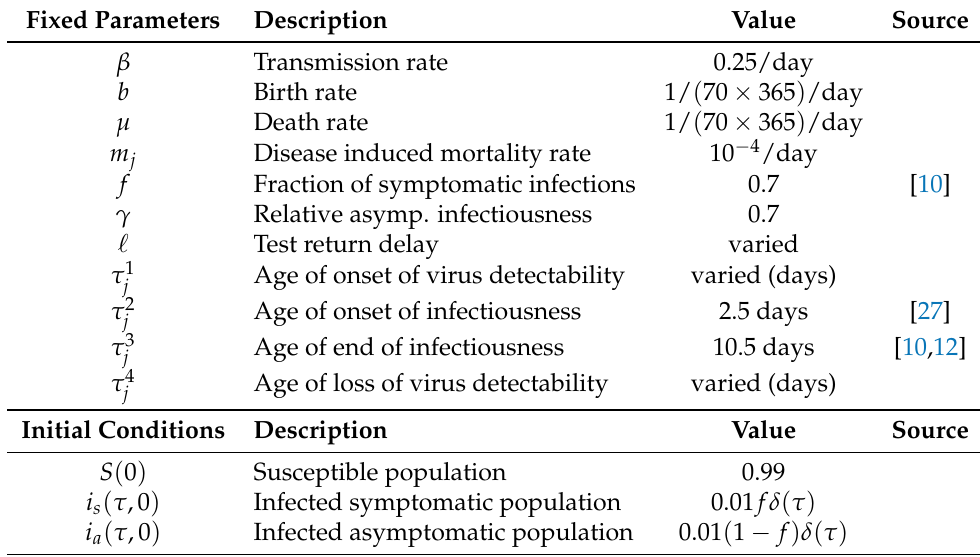
Table 2. Parameter values and initial conditions used in model Equation